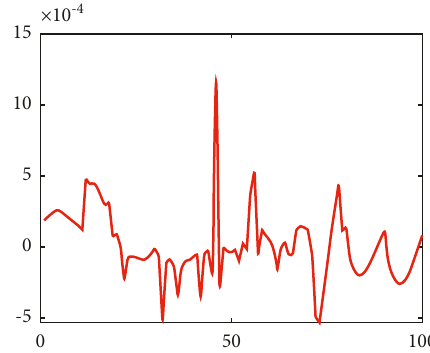
Figure 4: The error curve for inversion result of the “U-shaped”